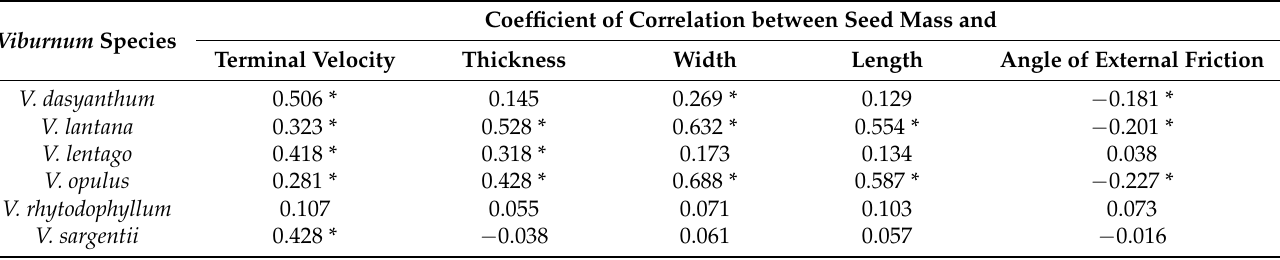
Table 2. Coefficients of linear correlation between seed mass and the remaining physical properties of viburnum